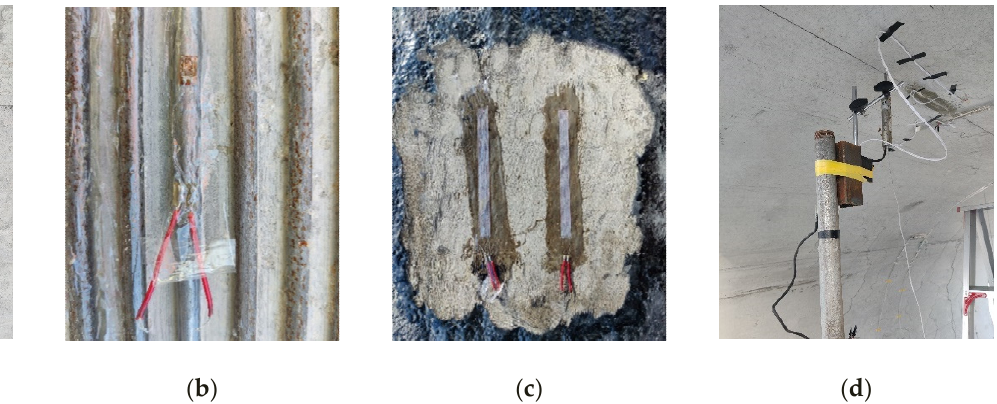
Figure 5. Strain gauge and displacement meter: ( a ) Concrete; ( b ) Prestressed steel wire; ( c ) Mortar; ( d ) Displacement meter.